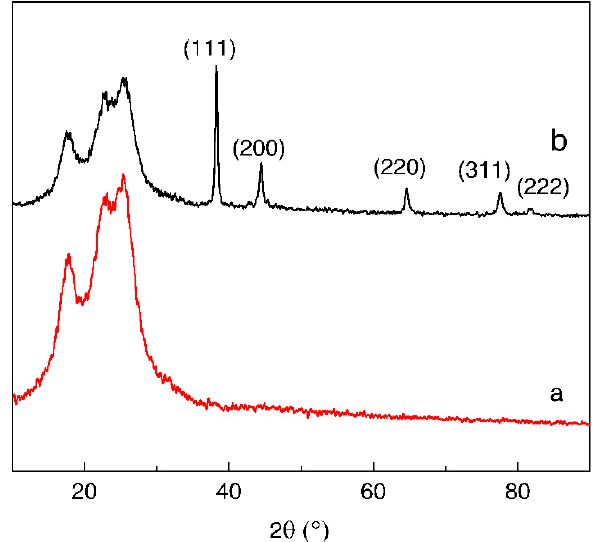
Figure 7. XRD patterns of the polyester fiber (a) before and (b) after silver plating.